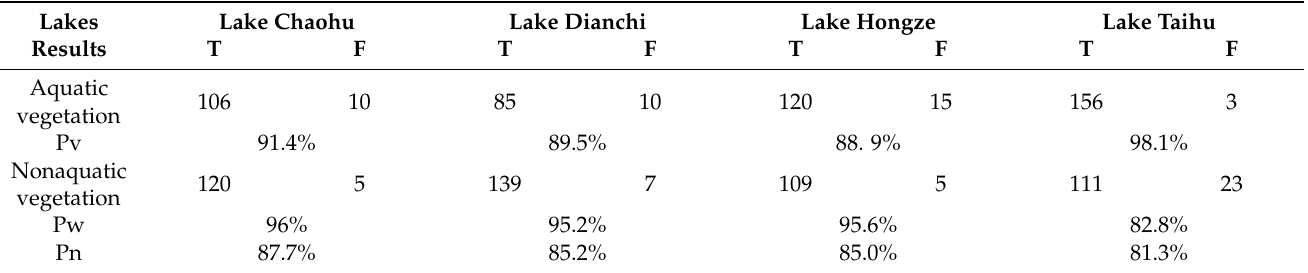
Table 2. Validation points number and the calculated accuracy results for the extent of aquatic vegetation and the extent of nonaquatic vegetation buffered outwards for